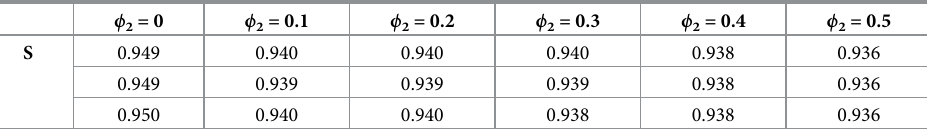
Table 1. Comparison of S values of the media with different proportions of reactive/less-cooperative cells whose surface is covered with randomly distributed firing cells with population density ϕ 1 = 0.5. ϕ 2 = 0 ϕ 2 =